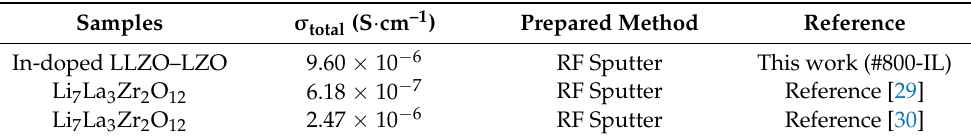
Table 3. The comparation of the ionic conductivity between this result with others.